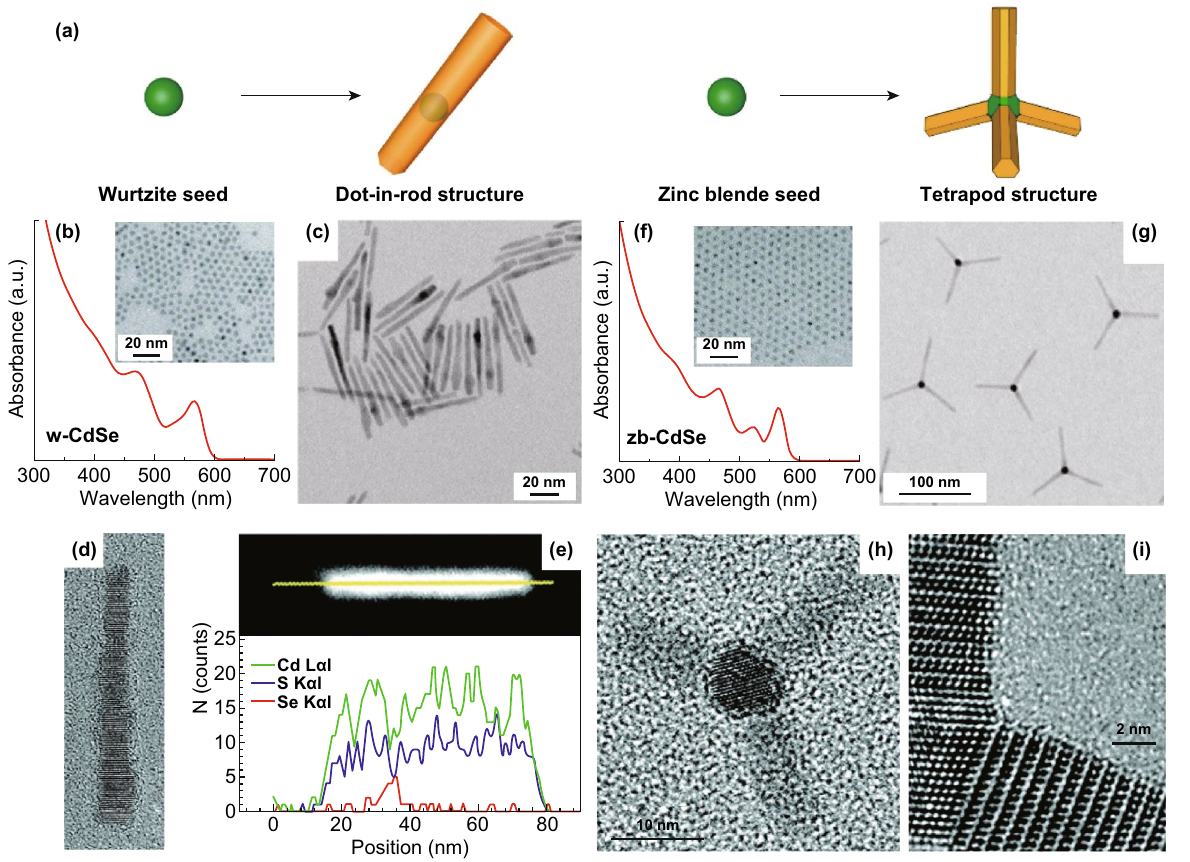
Fig. 2 a Schematic illustrations of dot‑in‑rod and dot‑in‑tetrapod structures obtained from wurtzite and zinc blende seeds, respectively. b Absorption spectrum and TEM image of 4.4‑nm CdSe NCs with wurtzite lattice. c TEM image of CdSe‑CdS dot‑in‑nanorod structures. d High‑resolution TEM image of a CdSe‑CdS dot‑in‑nanorod grown from a 4.4‑nm w‑CdSe seed. Scale bar, 5 nm. e High‑angle annular dark‑ field (HAADF) image of a CdSe‑CdS dot‑in‑rod and corresponding elemental profiles for Cd, S, and Se obtained by recording energy disper‑ sion spectroscopy signal intensities along the line shown in yellow in HAADF image. f Absorption spectrum and TEM image of 4.0‑nm CdSe nanocrystals with zinc blende lattice. g TEM images of CdSe/CdS tetrapods grown from 4.0‑nm zb‑CdSe seeds. h TEM image of a CdSe/CdS tetrapod grown from 4‑nm zb‑CdSe seed. i HRTEM image of a tetrapod fragment showing the interface between {111} planes of zb‑CdSe seed and {001} planes of w‑CdS arms. Reproduced with permission from Ref. [82]. Copyright 2007, American Chemical